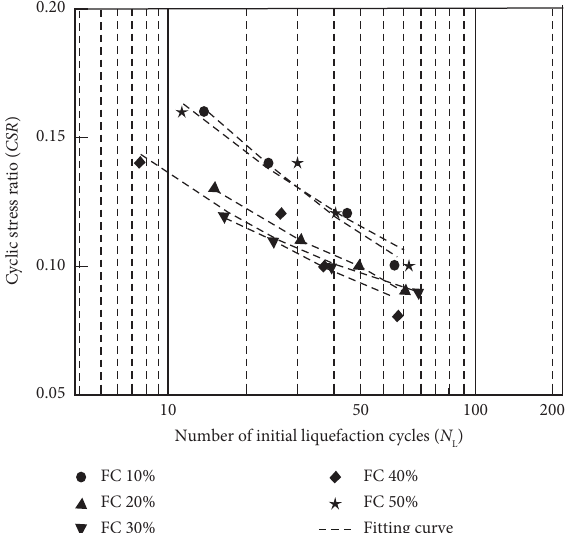
Figure 6: Correlations between the CSR and N